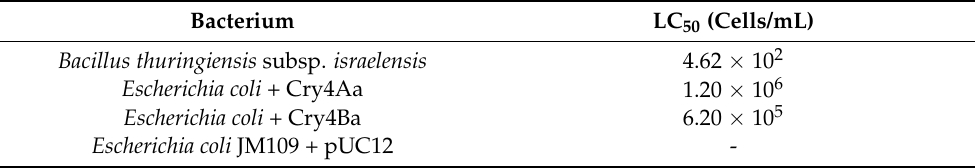
Table 1. Mosquito larvicidal activity of B. thuringiensis subsp. israelensis and E. coli expressing different Cry toxins against A. aegypti